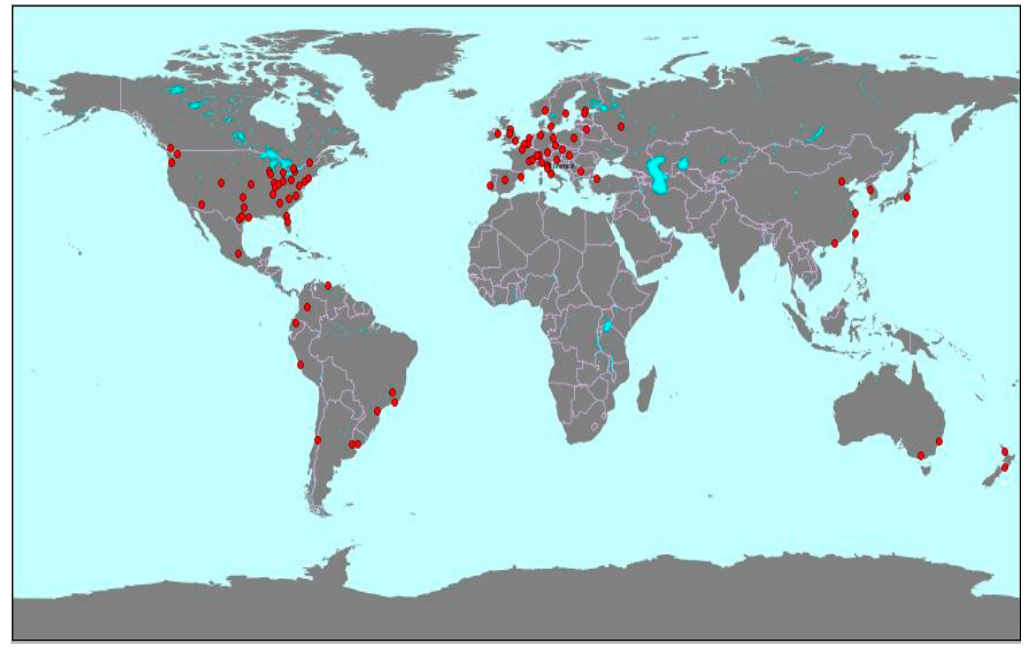
Figure 1. Distribution of analyzed cities.